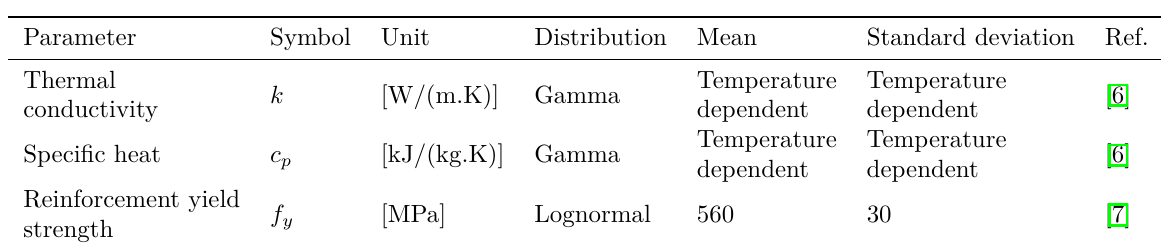
Table 1. Prior distribution for the parameters used in the Bayesian